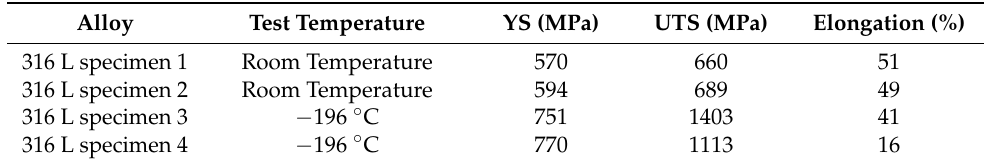
Table 3. Mechanical properties at room temperature and at − 196 ◦